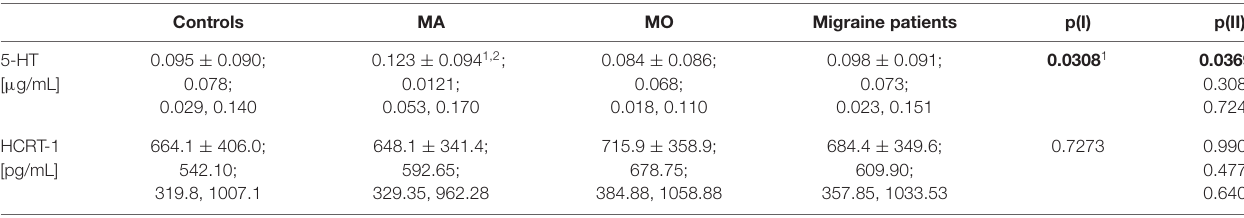
TABLE 4 | 5-HT and HCRT-1 concentration in MA, MO, both migraine patients (MA+MO) and controls.